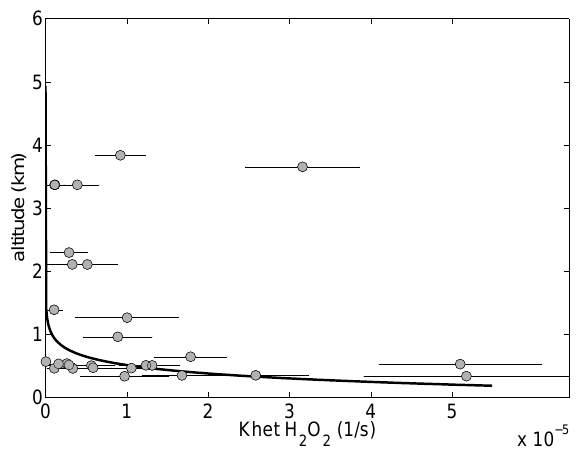
Fig. 5. Calculated heterogeneous removal rate khet(H 2 O 2 ) as a function of altitude, as caused by wet and dry deposition processes.